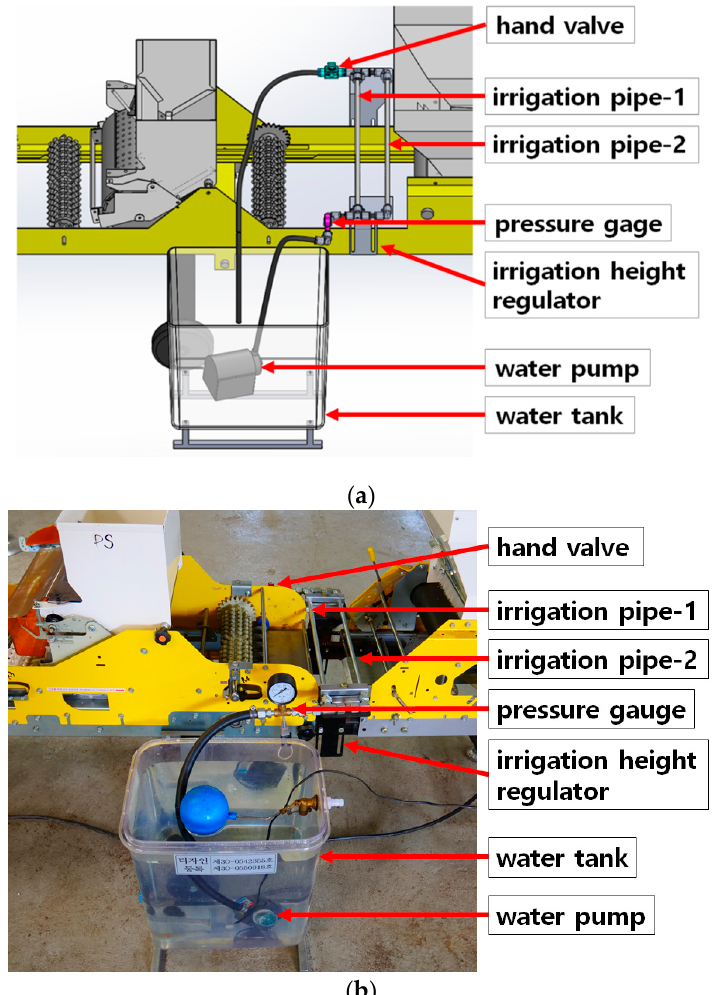
Figure 7. Irrigation system mounted on a roller-type onion pot-seeding machine: ( a ) 3D modeling; ( b ) picture of real system.